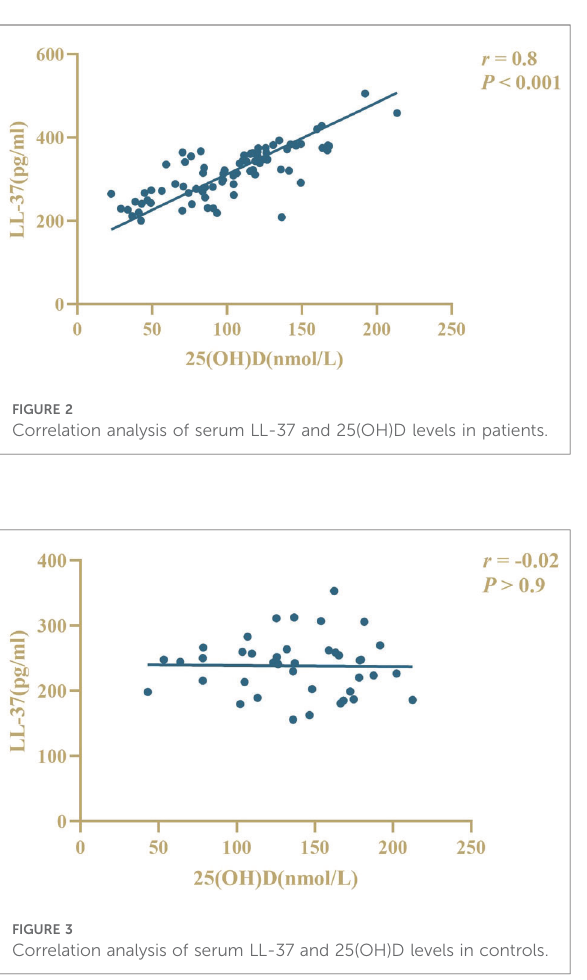
TABLE 2 Correlation of serum 25(OH)D and LL-37 with clinical data in